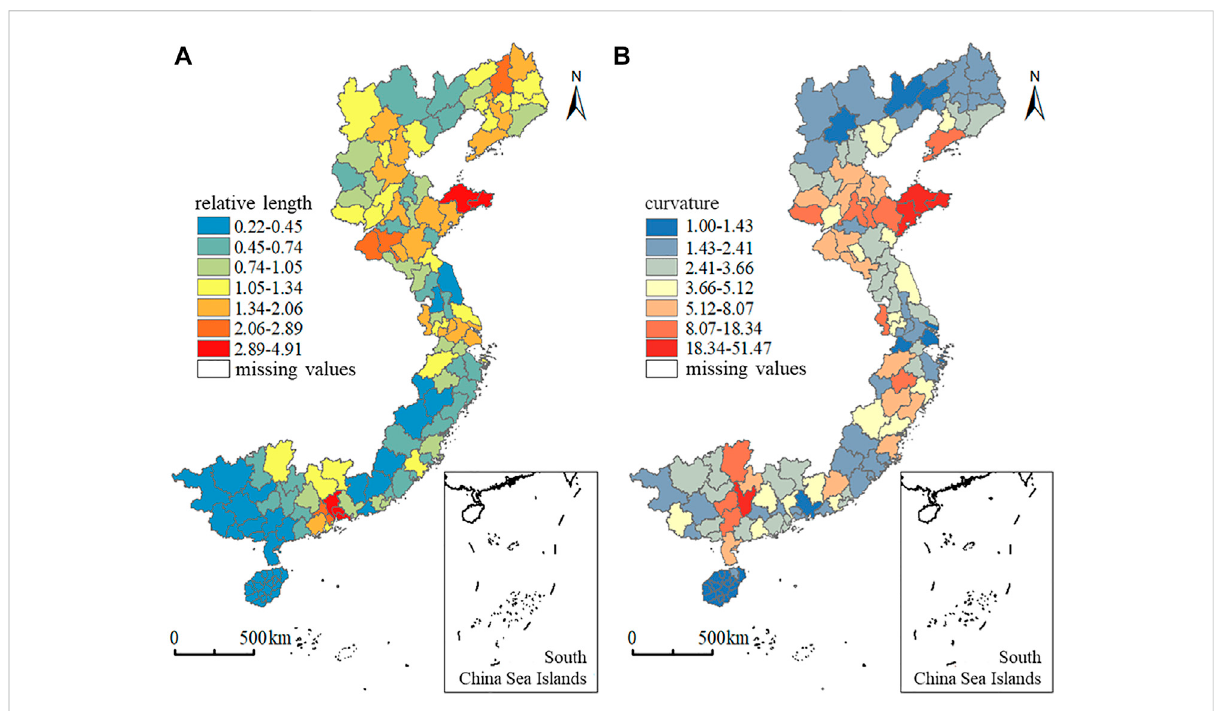
FIGURE 8 Relative length (A) and curvature (B) of net carbon emission time